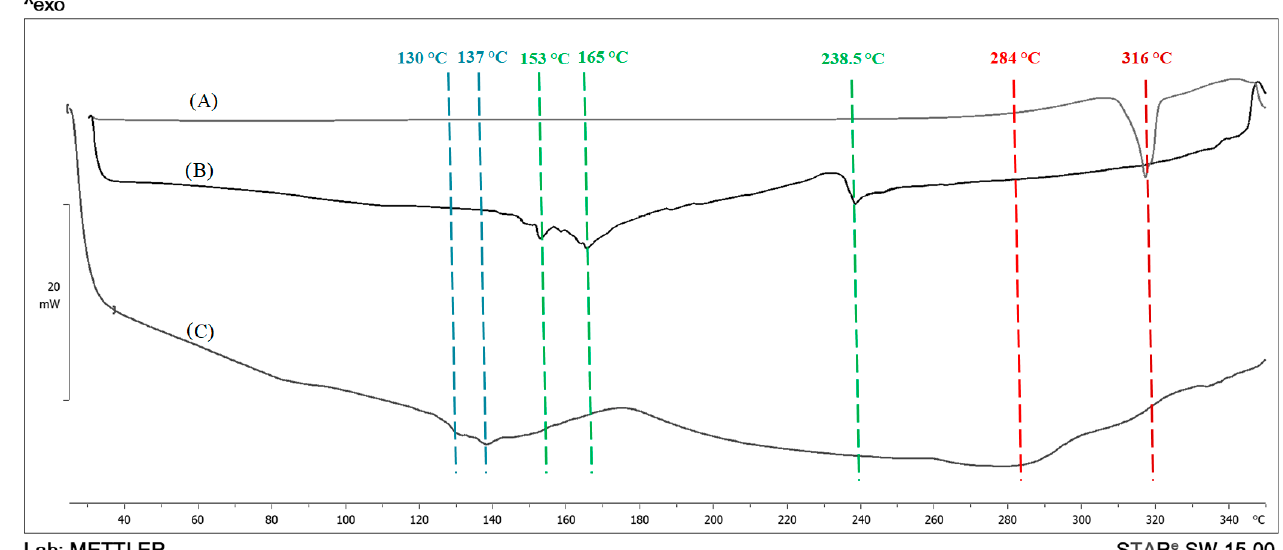
Figure 6. DSC thermograms of: ( A ) QC, ( B ) phospholipid and ( C ) optimized formulation.